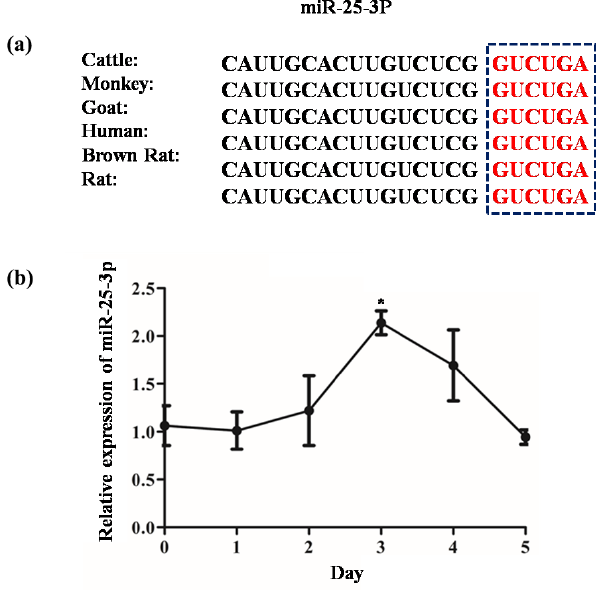
Figure 2. The relative expression levels of miR-25-3p during differ- entiation of goat intramuscular preadipocytes. (a) Mature miR-25- 3p seed region was highly conserved among mammals. (b) miR-25- 3p expression pattern during differentiation of goat